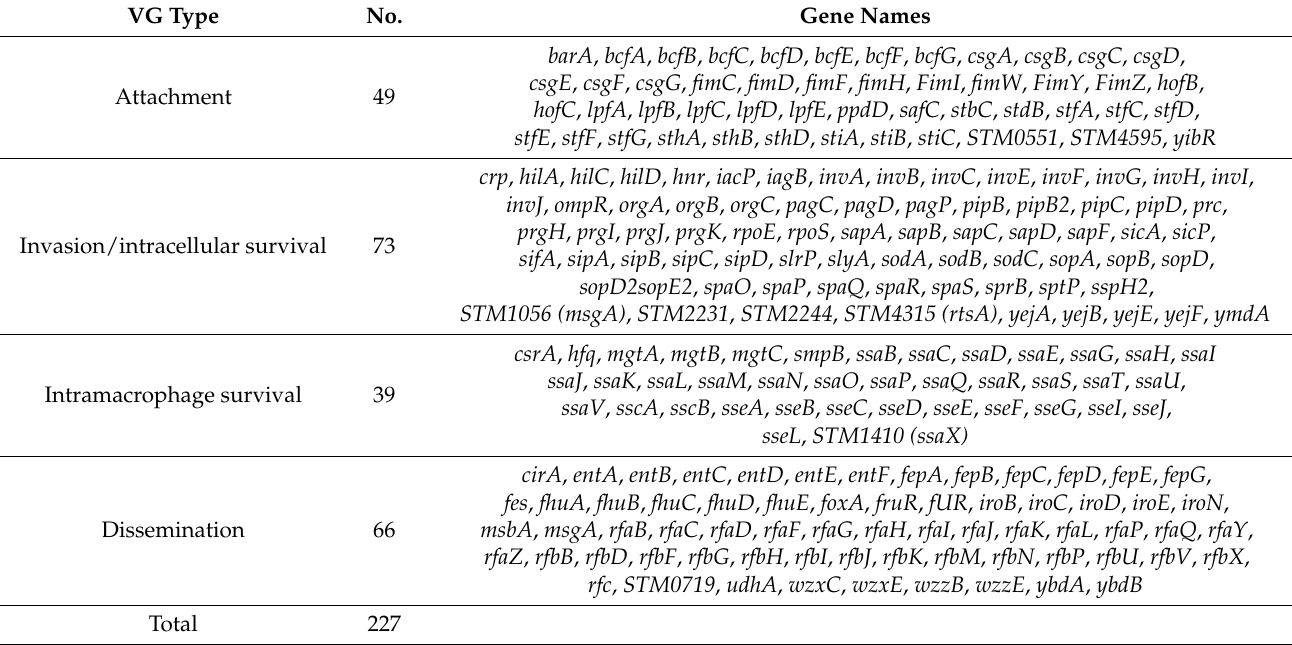
Table 4. Virulence genes involved in the four known steps of Salmonella